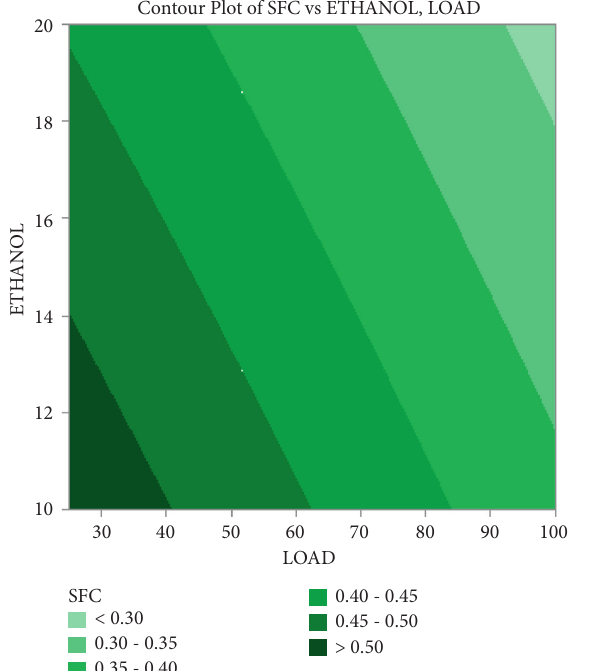
Figure 7: Contour plot of fuel consumption on load and ethanol blend.